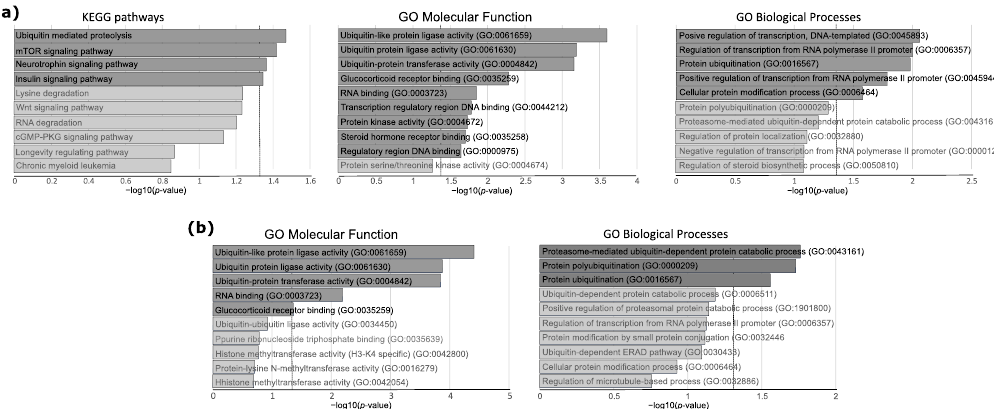
Figure 2. Gene Set Enrichment analysis of genes that were identified as regulated by miRNAs differentially expressed in USP8 mut and USP8 wt corticotroph tumors. ( a ) Results of the analysis of all putative target genes ( n = 400). ( b ) Results for putative target genes with negative miRNA – mRNA correlation of expression levels ( n = 239). Top 10 enriched pathways/processes are presented. Dark gray bars indicate significantly enriched pathways/processes (adjusted p < 0.05). Vertical dashed line indicates the significance threshold.